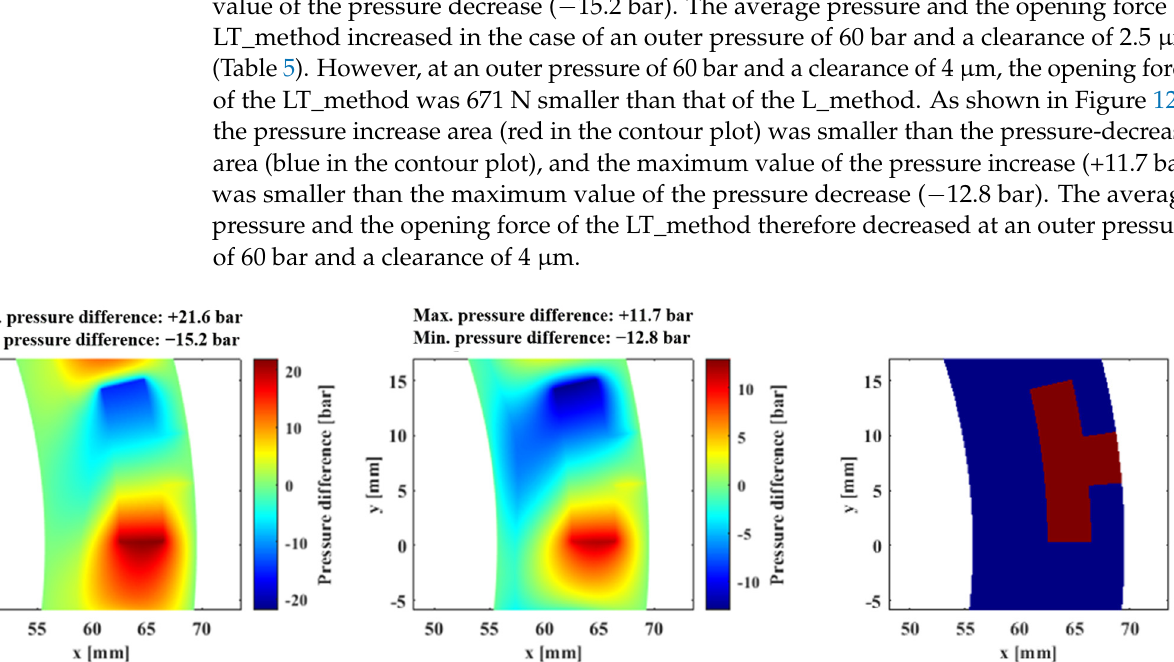
Figure 13. Pressure difference between the LT_method and the L_method for a fluid film of 2.5 μ m ( a ) and 4 μ m ( b ) corresponding to T-groove geometry ( c ). Outer pressure = 6 bar. In Tables 5 and 6, the change in the opening force due to slippage is small compared with the effect of turbulence. As shown in Figure 11, no slippage occurs in the groove, and it occurs primarily near the inner radius. This explains why there is no maximum pressure difference due to the slip effect. Figure 14a,b shows the pressure difference between the LTS_method and the LT_method at an outer pressure of 6 bar. Figure 14c shows the ge- ometry corresponding to Figure 14a,b. The pressure difference decreased in most areas and the maximum values of the pressure decreases of − 0.079 bar in Figure 14a and − 0.052 bar in Figure 14b are larger than those of the pressure increase of +0.004 bar in Figure 14a and +0.003 bar in Figure 14b. However, the maximum value of the pressure difference was